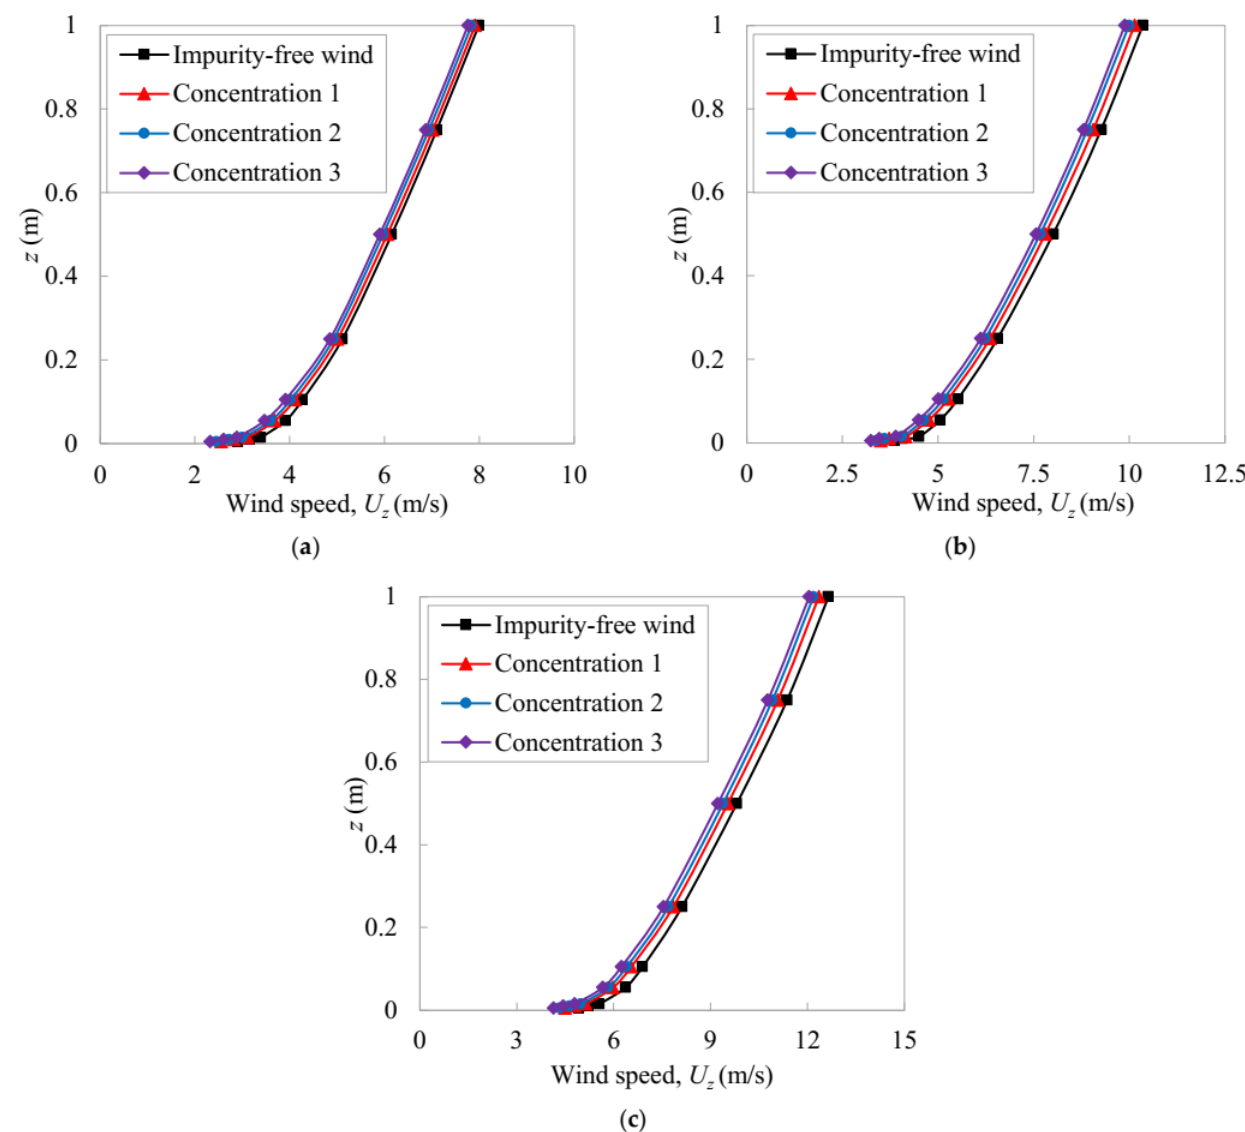
Figure 7. Wind speed profiles: ( a ) At the test wind speed of 10 m/s; ( b ) At the test wind speed of 13 m/s; ( c ) At the test wind speed of 16